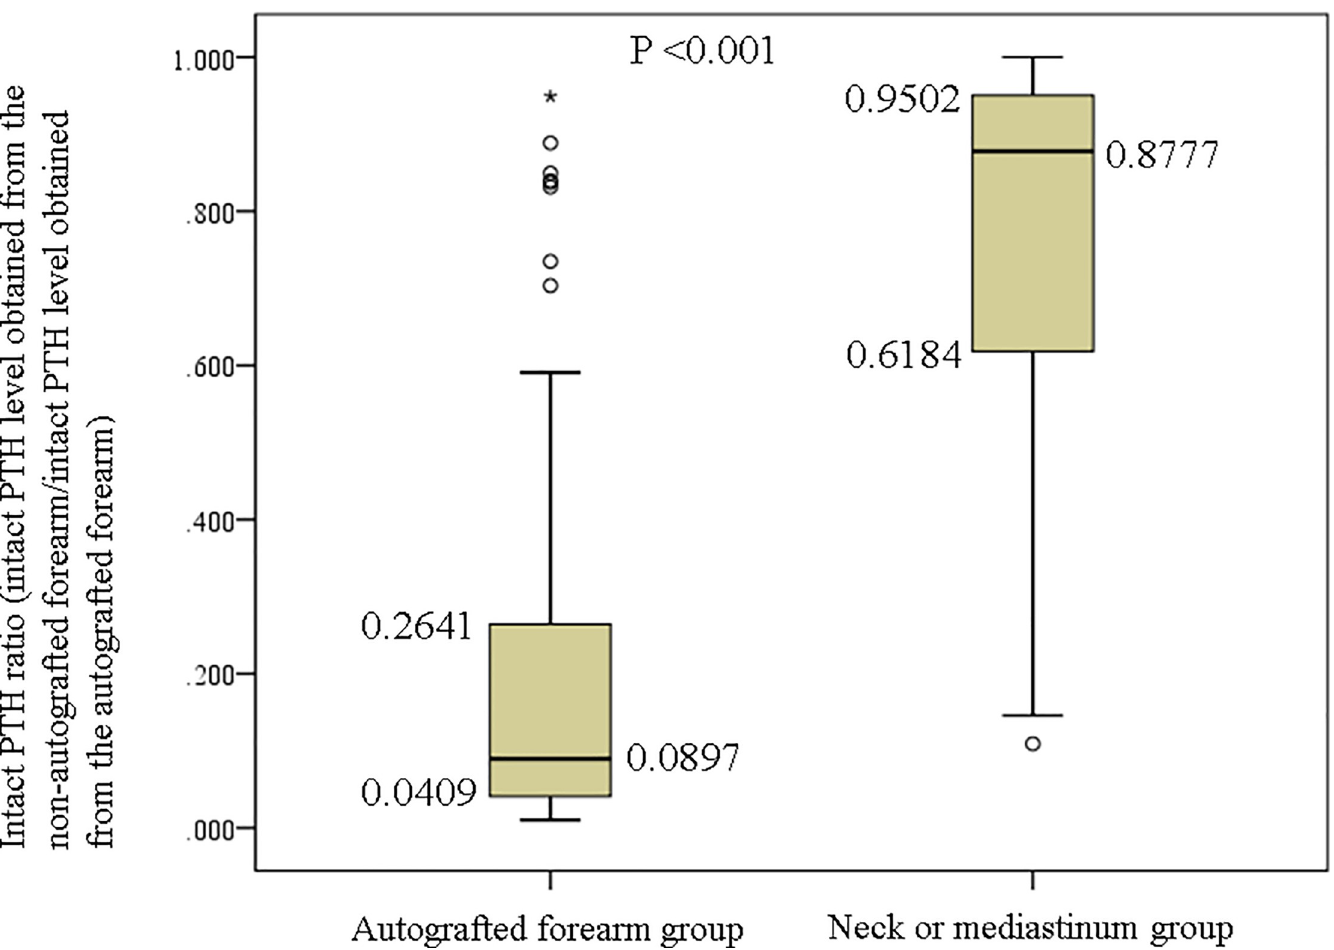
Fig 4. Comparison of intact PTH ratios in the autografted forearm group and the neck or mediastinum group. PTH, parathyroid hormone.